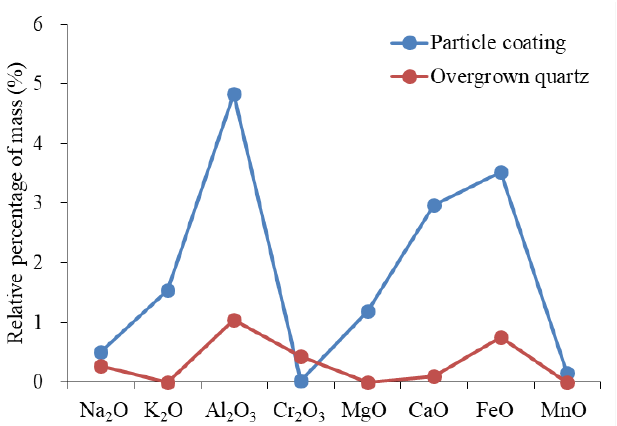
Figure 13. Composition distribution of particle coating and overgrown quartz.